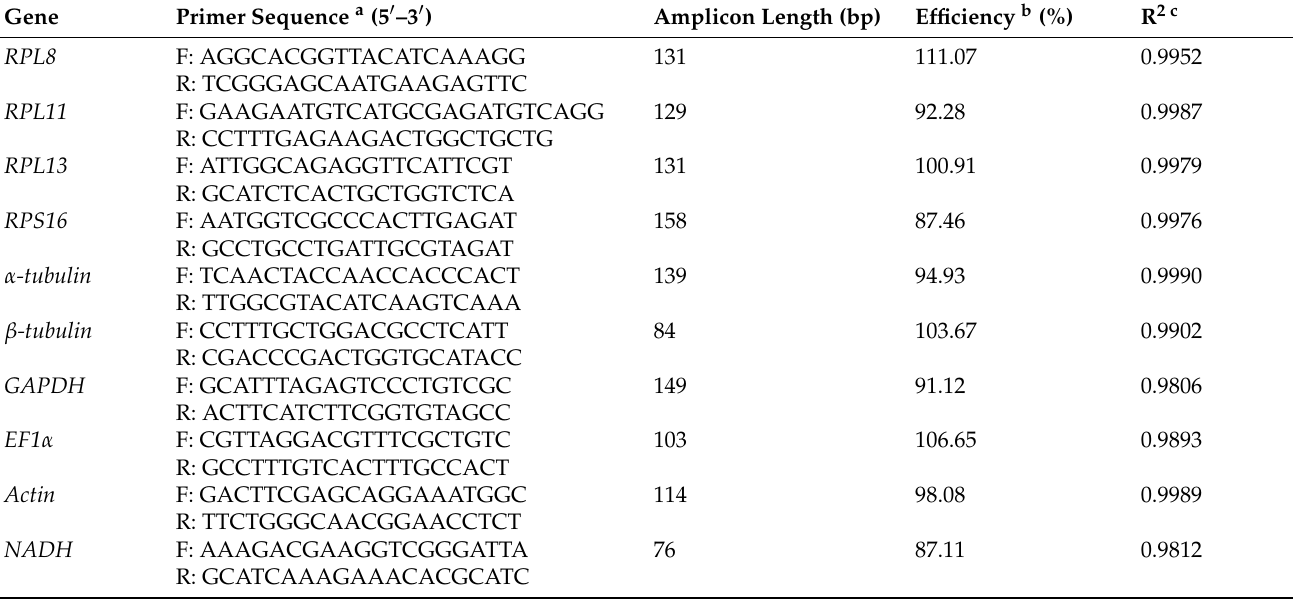
Table 1. The primer sets and amplification efficiency of the 10 candidate reference genes used for